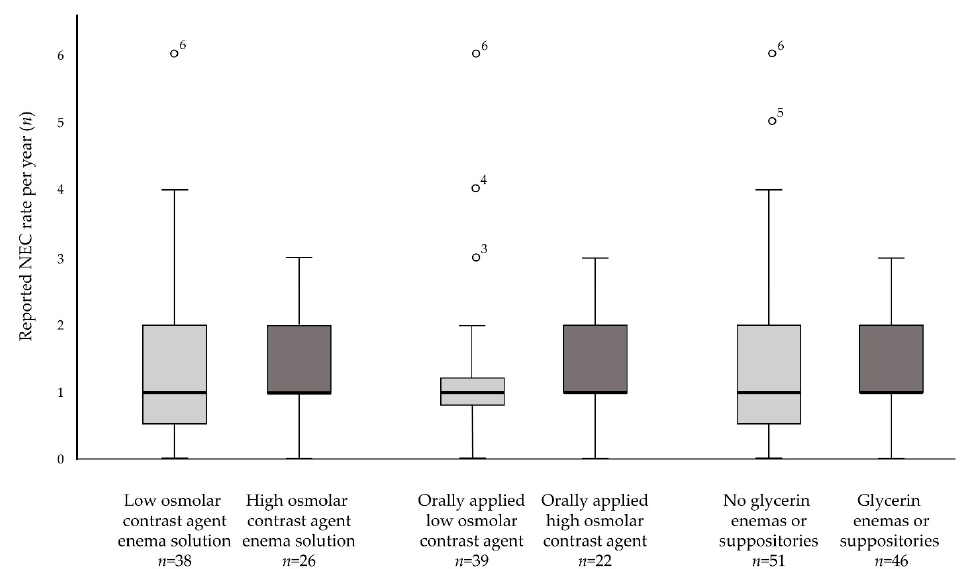
Figure 1. Boxplot distribution of reported NEC rate per year and interventions used (high vs. low contrast agents; use vs. no use of glycerin enemas and suppositories). Dots indicate outlier values. NEC rate was provided by 99 participating units. NEC—necrotizing enterocolitis.